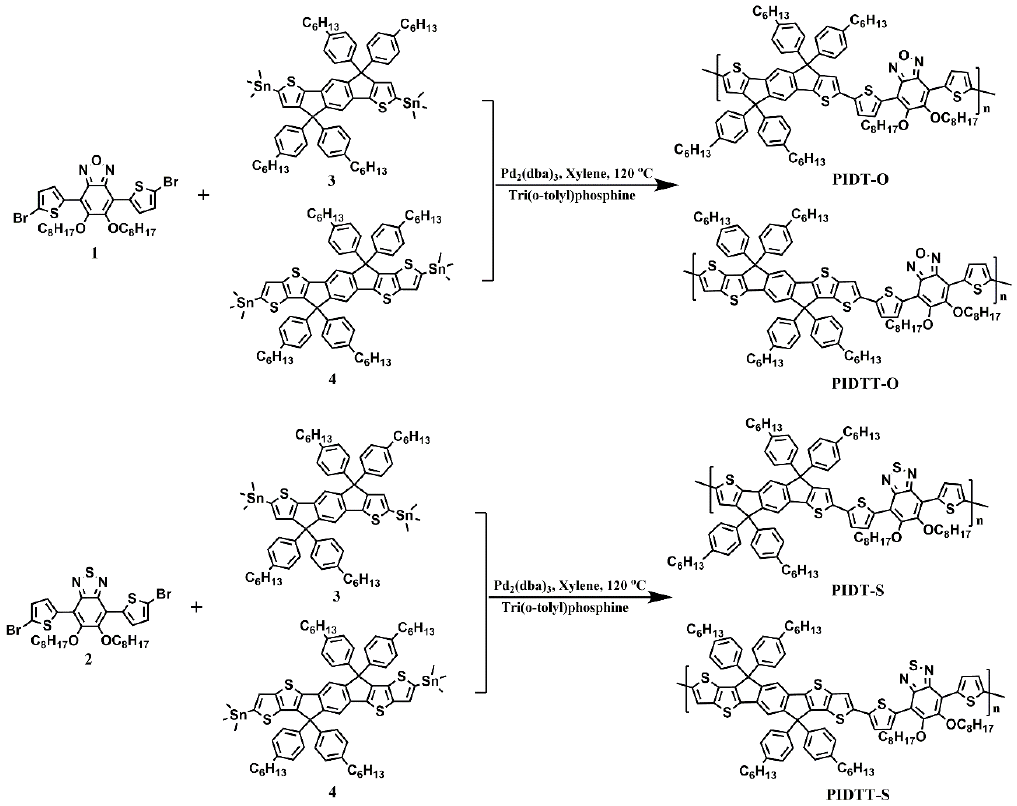
Scheme 1. Synthetic routes of the polymers. Table 1. Molecular weights and thermal properties for the polymers.